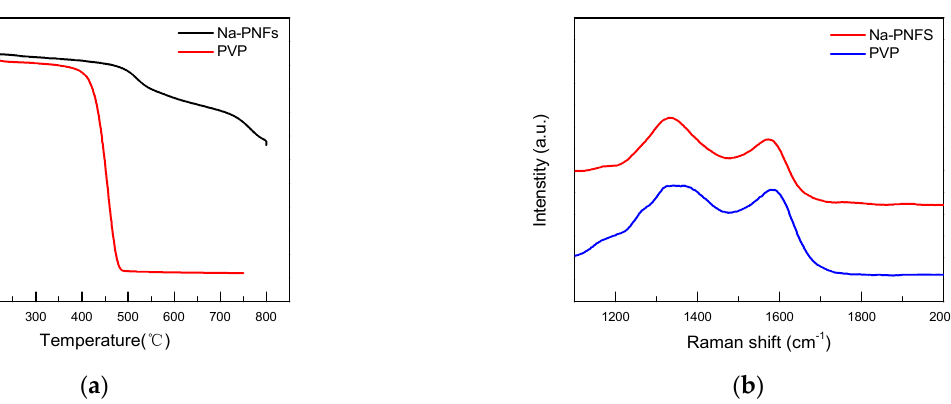
( b ) Figure 10. TGA curves of ( a ) Cu@organic; ( b ) Cu@MC under air atmosphere. The Cu@MC pellet had a high electrical resistivity of 7.27 × 10 − 3 Ω ·cm at room tem- perature (Table 1), which is about 5 times higher than the graphene-wrapped Cu NPs reported previously. The high stability and conductivity suggest that the copper nanopar- ticles were fully wrapped by the carbon shell. Table 1. Electrical resistivity of the carbon-coated copper powder. Sample